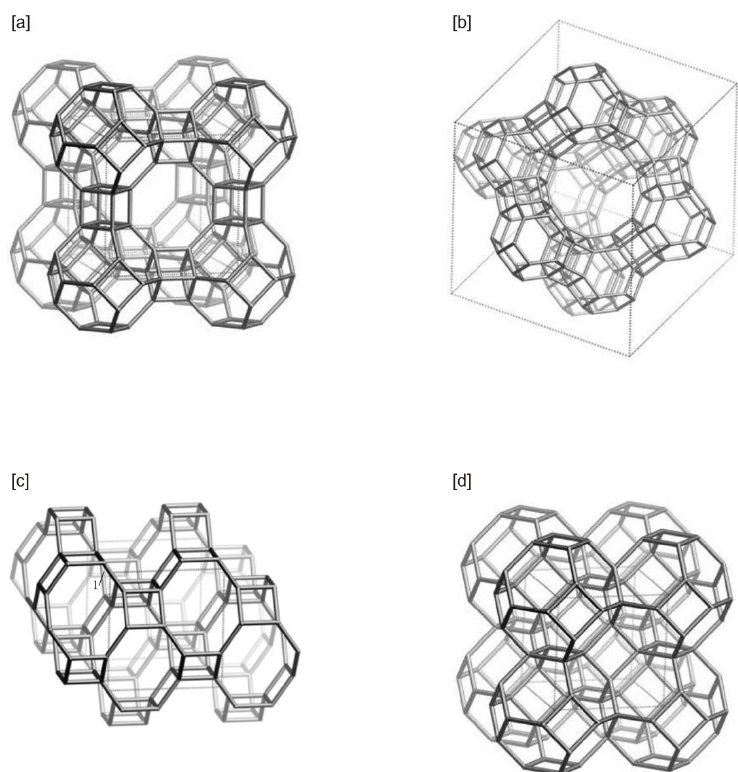
Figure 6. Structure of common synthetic zeolite frameworks. ( a ) Zeolite A (LTA: viewed along [001]); ( b ) faujasite (viewed along [110]); ( c ) zeolite P (viewed along [100]); and ( d ) sodalite (viewed along [001]). Modified from the Structure Commission of International Zeolite Association.